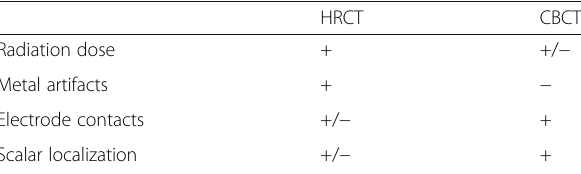
Table 3 Comparison of HRCT and CBCT in evaluation of cochlea implants